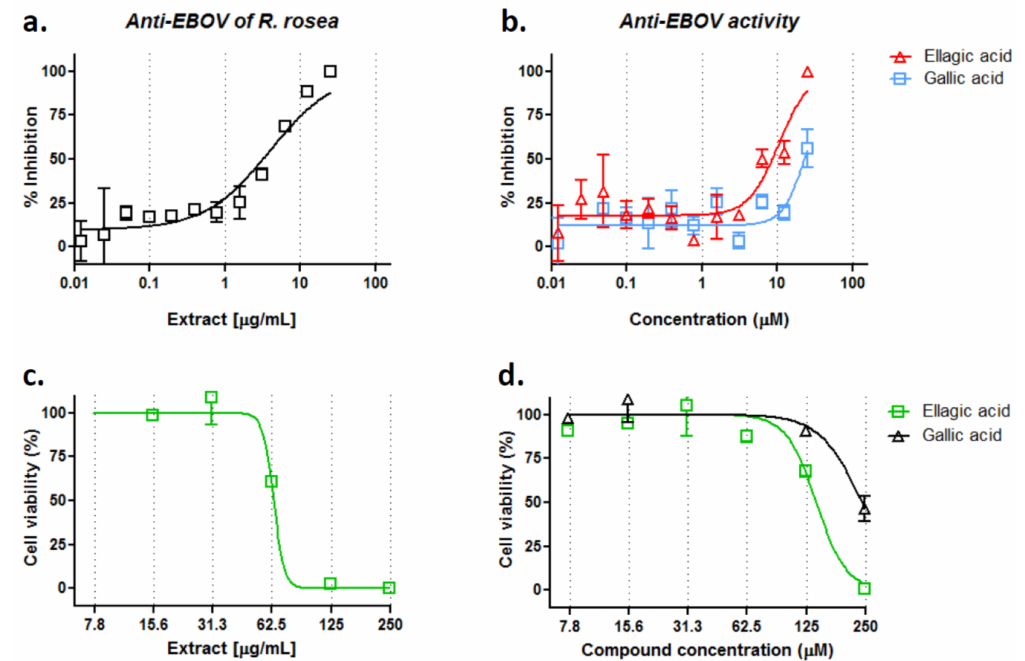
Figure 4. Anti-filovirus activities of R. rosea extract, ellagic acid and gallic acid against infectious EBOV. Dose-response titrations were evaluated in Hela cells against recombinant infectious EBOV-green fluorescent protein (GFP) infection for ( a ) R. rosea extract and ( b ) ellagic acid and gallic acid. Cell viability assays of ( c ) R. rosea extract and ( d ) ellagic acid and gallic acid were performed in Hela cells. Data are means ± SD ( n =